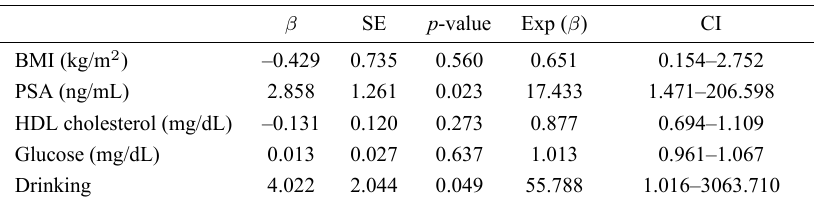
Table 4. Multivariate analysis results based on logistic regression performed to examine the parameters contributing to prostate biopsy